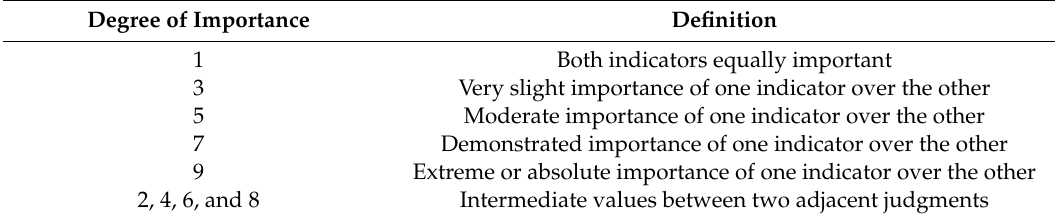
Table 3. The analytic hierarchy process (AHP) pairwise comparison scale.